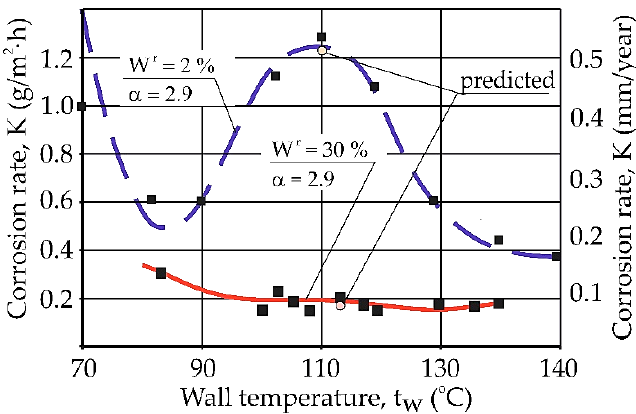
Figure 8. Dependences of corrosion rate K on wall temperature t w.